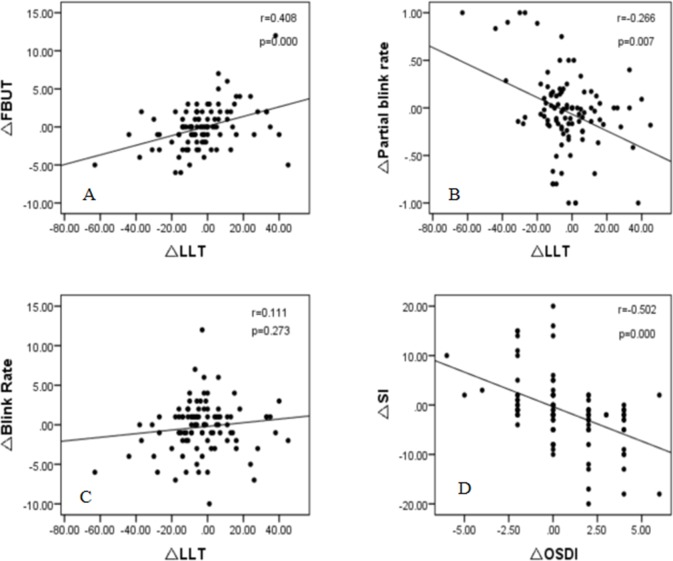
Correlation between the changes in LLT and FBUT (A), the changes in LLT and incomplete blinking rate (B), the changes in LLT and blink rate (C), and the changes in OSDI and SI (D) from preoperative to 3-month postoperative measurements.